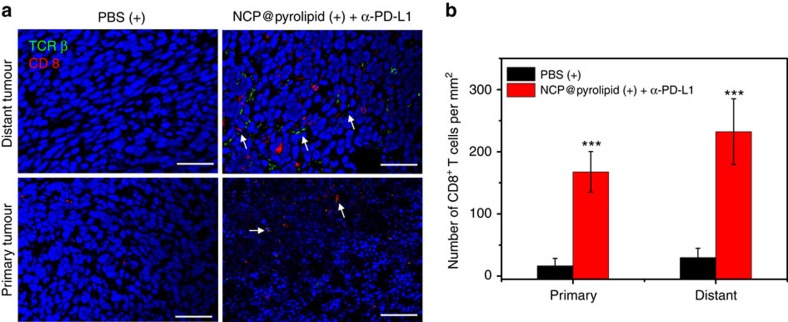
CD8+ T cells immunofluorescence assay.Bilateral tumour models of MC38 were established and treated with PBS with irradiation or NCP@pyrolipid with irradiation plus anti-PD-L1. On Day 19 (12 days after the first treatment), primary (right) and distant (left) tumours were collected, sectioned and subjected to immunofluorescence staining. (a) Representative CLSM images of tumours after immunofluorescence staining. White arrows indicate CD8+ T cells. Tumour cell nuclei in treated primary tumours appear to be smaller, probably due to the effects of PDT treatment. Scale bar, 50 μm. (b) The densities of CD8+ T cells in the whole tumours. Data are expressed as means±s.d. (n=3). ***P<0.001 from control by t-test.